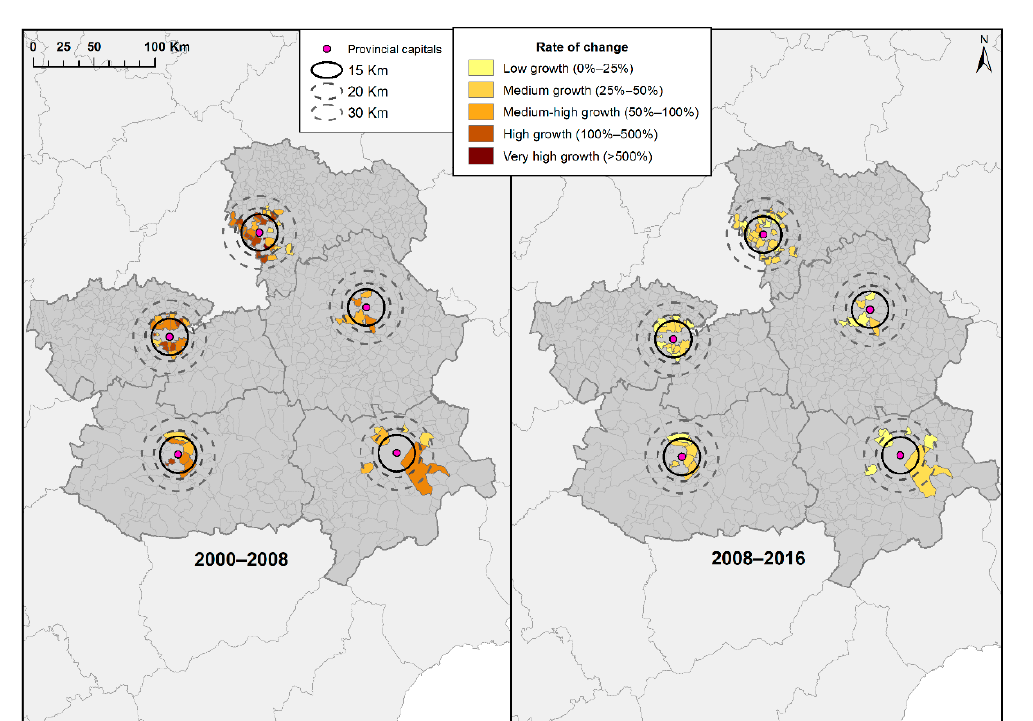
1 Source: Cadastre for dwellings; National Statistics Institute (INE) for population. Own preparation.